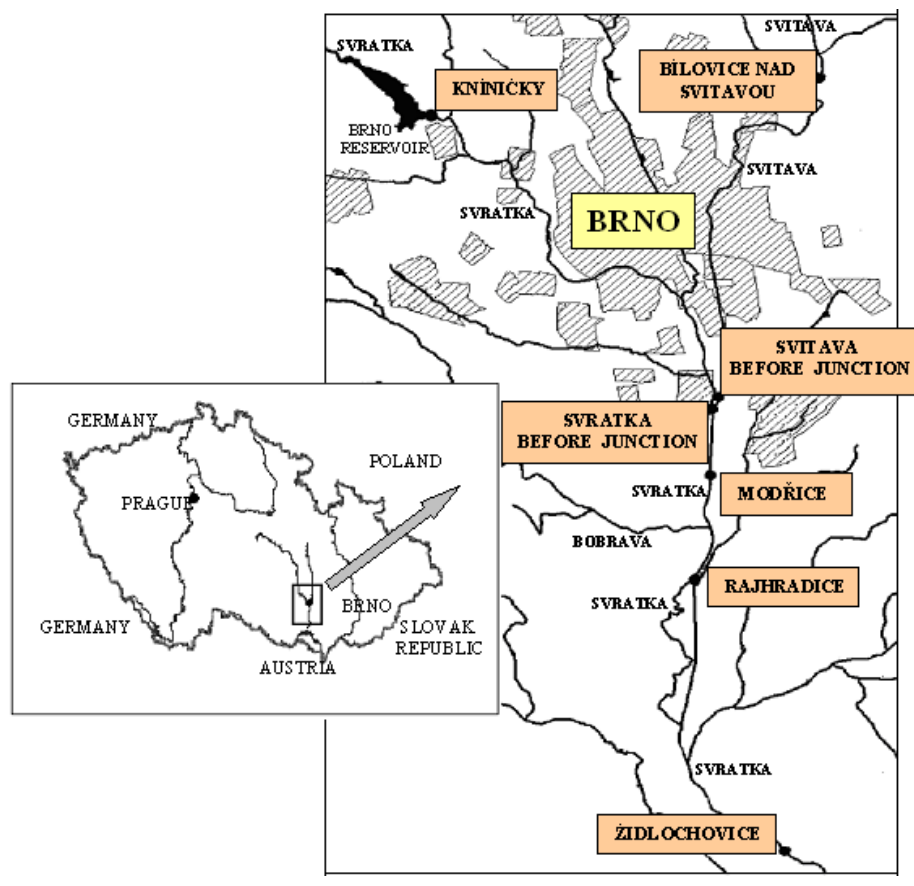
Figure 2. Study areas on the Svitava and Svratka rivers (Czech